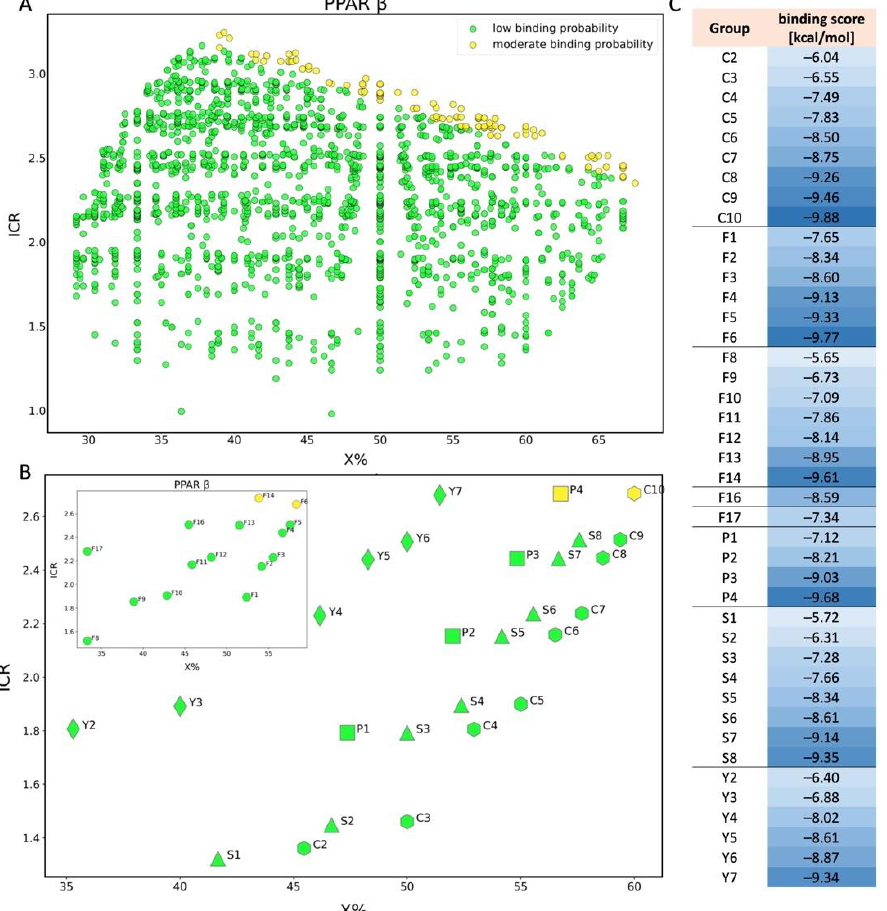
Figure 5. Scatter plot of binding scores obtained for PPAR β in X% and ICR space ( A ); Scatter plot for PPAR β showing the division of PFAS into 5 different structural groups in space of X% and ICR. C-carboxylic acids (COOH-(CF2)n-CF3), S-sulfonic acids (SO3H-(CF2)n-CF3), P-phosphonic acids (PO3H2-(CF2)n-CF3, F-Fluorotelomer alcohol (F1-F7(OH-(CH2)-(CF2)n-CF3), F8-F14 (OH-(CH2)2- (CF2)n-CF3), F16 (OH-(CH2)3-(CF2)n-CF3), F17 (OH-(CH2)4-(CF2)n-CF3)), Y-dicarboxylic acids (COOH-(CF2)n-COOH). Colors: green-low binding probability, yellow-moderate binding probability ( B ); table showing binding score values for each compound shown in chart B ( C ).